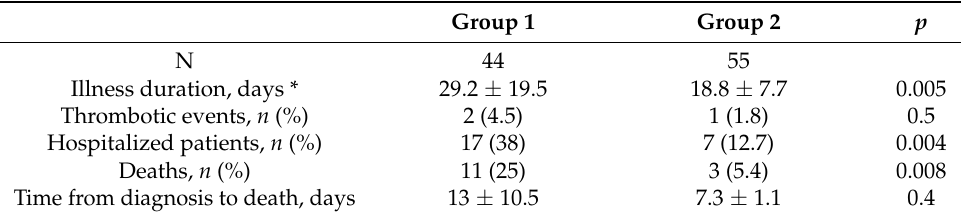
Table 4. Clinical outcomes of hemodialysis patients affected by COVID-19 during the different periods evaluated.